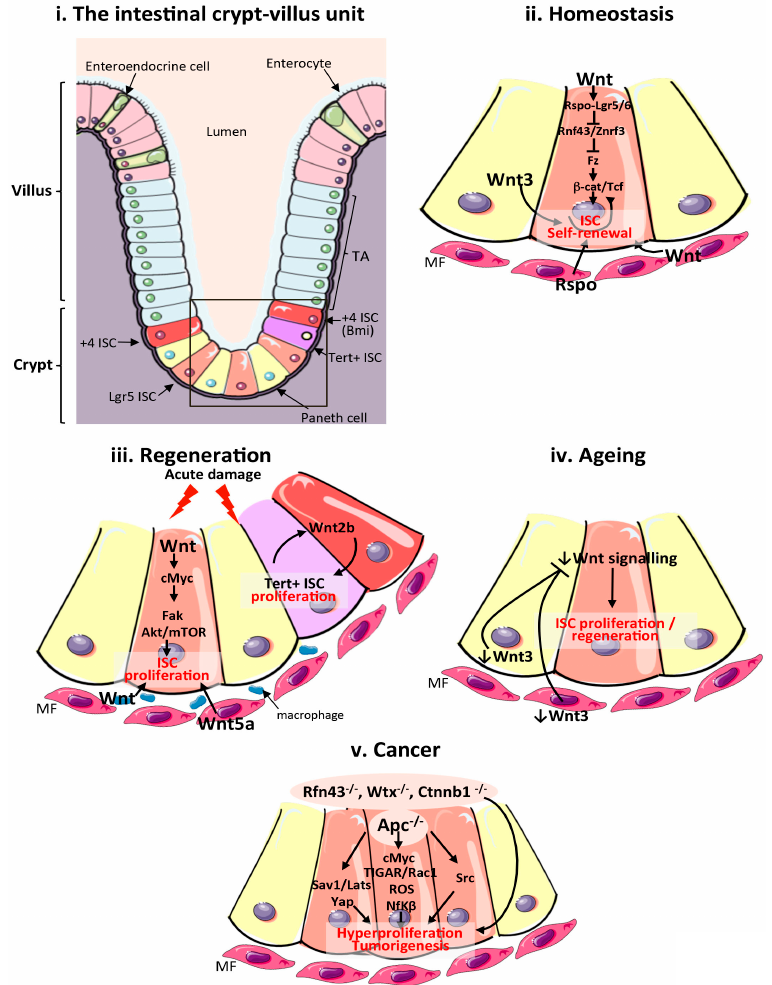
Figure 1. Wnt signalling in the mammalian intestine during homeostasis, regeneration, ageing and cancer. ( i ) Schematic of the cellular composition and architecture of a crypt–villi unit in the mammalian intestine. The stroma is depicted in purple and the gut lumen in peach. The boxed area highlights the crypt and stem cell niche, which are magnified in ( ii – v ); ( ii ) Main sources of the Wnt stem cell niche and pathway activation during intestinal homeostasis. Wnt3 from Paneth cells, and Wnt and Rspo from mesenchymal and epithelial stem cell niches are important sources of Wnt during homeostasis; ( iii ) Sources of the Wnt stem cell niche and pathway activation during intestinal regeneration following damage. Wnt2b signalling from intestinal epithelial cells is required to activate proliferation of quiescent Tert + intestinal stem cells (ISCs). Wnt from macrophages and Wnt5a from the mesenchyme are also important sources of Wnt during regeneration. Wnt activation of cMyc is known to target Fak and Akt/mTOR pathways to increase ISC proliferation in response to damage; ( iv ) Reduced production of mesenchymal and Paneth cell Wnt3 and canonical Wnt pathway activity in the ageing intestinal epithelium impairs ISC proliferation; ( v ). Wnt pathway activation during intestinal tumourigenesis and functional pathways activated following Apc loss. ISCs: intestinal stem cells; TA: transit amplifying cells; Tert: telomerase reverse transcriptase; MF: mesenchymal fibroblasts; Apc: Adenomatous polyposis coli; Fak: focal adhesion kinase; ROS: reactive oxygen species; TIGAR: TP53-inducible glycolysis and apoptosis regulator; Rspo: R-Spondin; Sav1: Salvador 1; mTOR: mammalian target of rapamycin; Yap1: Yes associated protein 1; Lats: Large tumour suppressor kinase 1; Nf- κβ : Nuclear factor κβ .